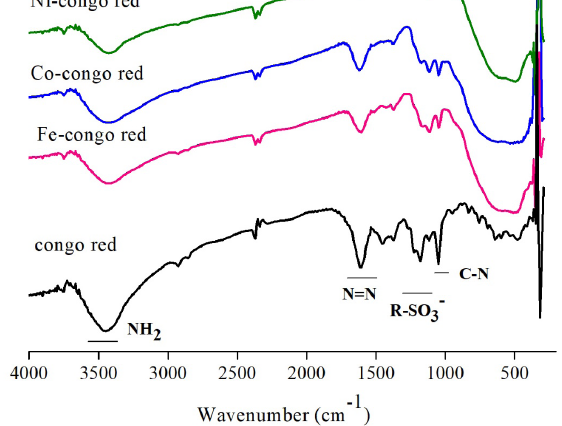
Table 3: Conductance analysis of complex compounds. Compound